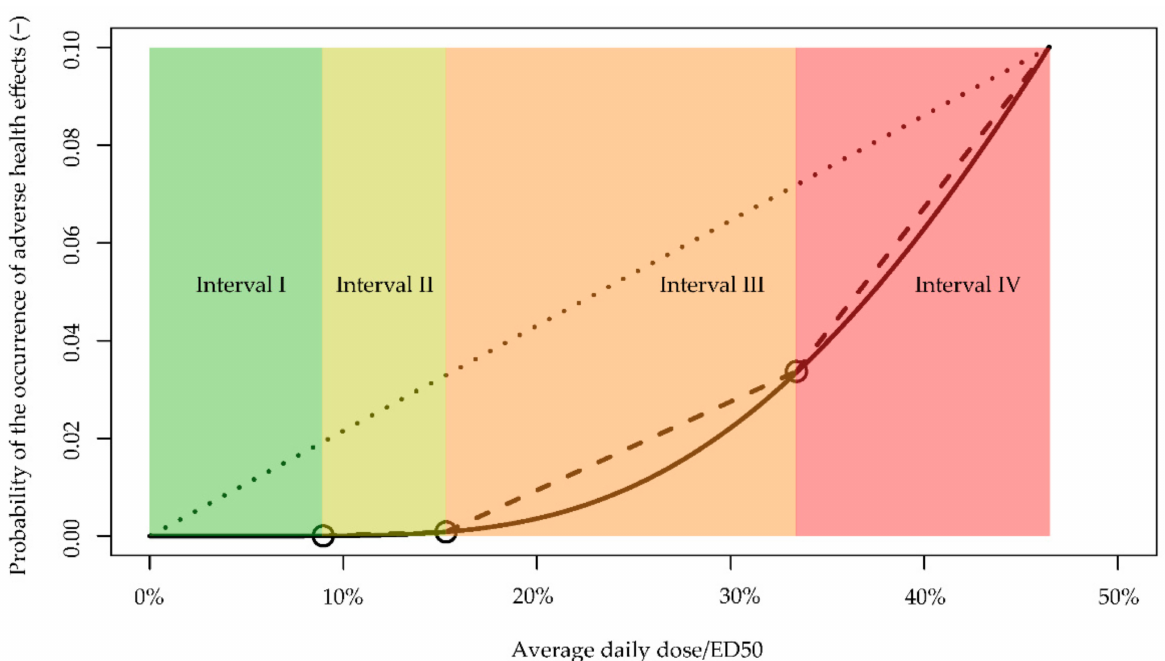
Figure 4. Nonlinear dose–response curve (solid line), approximated linear slopes for four intervals (dashed lines), and extrapolated slope based on ED 10 (dotted line). Circles are starting/end points for the intervals.